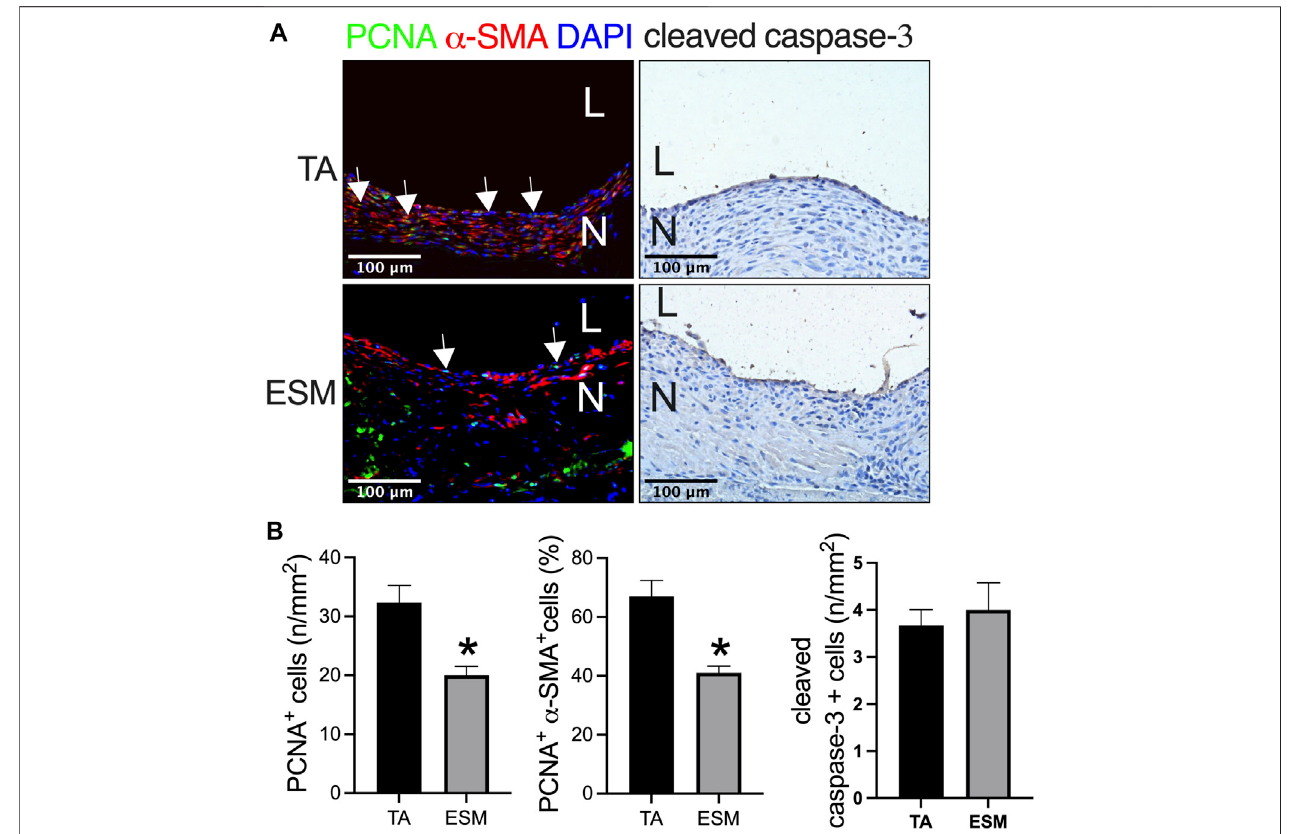
FIGURE4| NeointimalcellturnoverafterTAandESMpatchangioplasty. (A) Photographofimmuno fl uorescencestainingforPCNA(green), α -actin(red),andDAPI (blue);photographofimmunohistochemistrystainingforcleavedcaspase-3;scalebar,100 μ m;L,lumen;N,neointima;whitearrowsshowthepositivecell, n =3. (B) Bar graphsshowingtheneointimalPCNA-positivecellnumbers(* p =0.0208, t -test),PCNAand α -actindual-positivepercentage (* p =0.0121, t -test),andcleavedcaspase- 3-positive cell numbers (* p = 0.6433, t -test) after TA and ESM patch angioplasty; n =